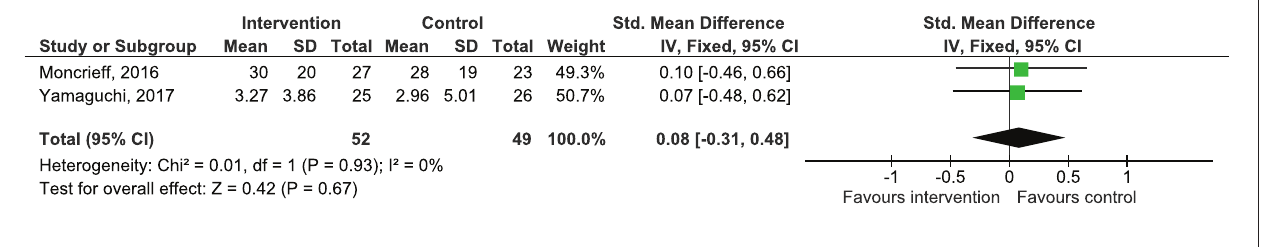
identified from the studies. The random-effects meta-analysis revealed no significant effect of digital SDM interventions to improve side effects induced by medication (two studies, N = 102, SMD = 0.08, CI: − 0.31, 0.48, p = 0.67) (22, 31).